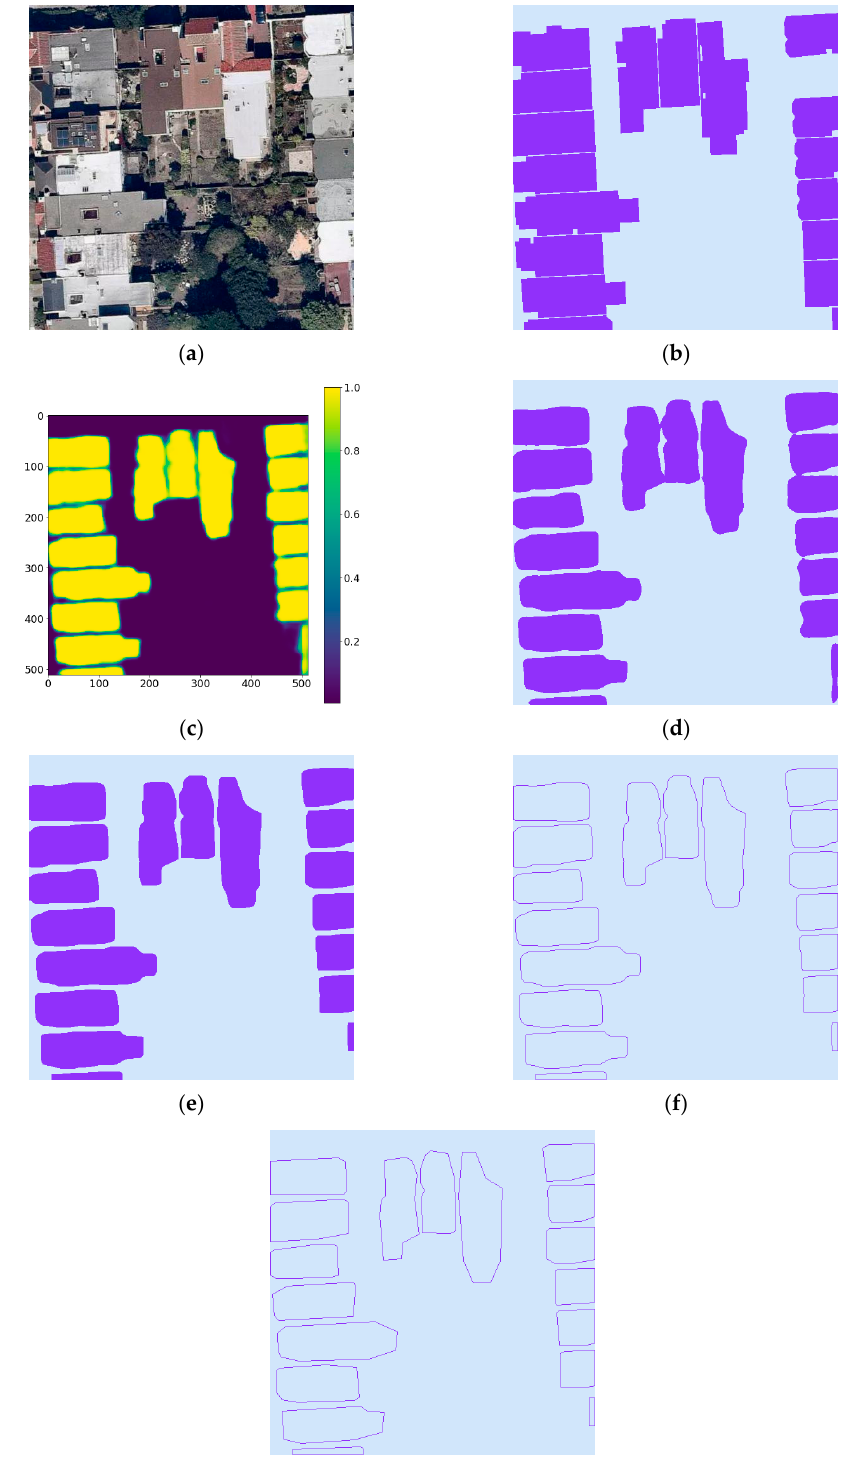
Figure 2. Example of steps 1 to 4 of the postprocessing. ( a ) Remote sensing image; ( b ) scaled ground truth mask; ( c ) predicted probabilities map; ( d ) converted binary mask; ( e ) mask after morphological operation; ( f ) result of mask polygonization; ( g ) polygons after simplification.